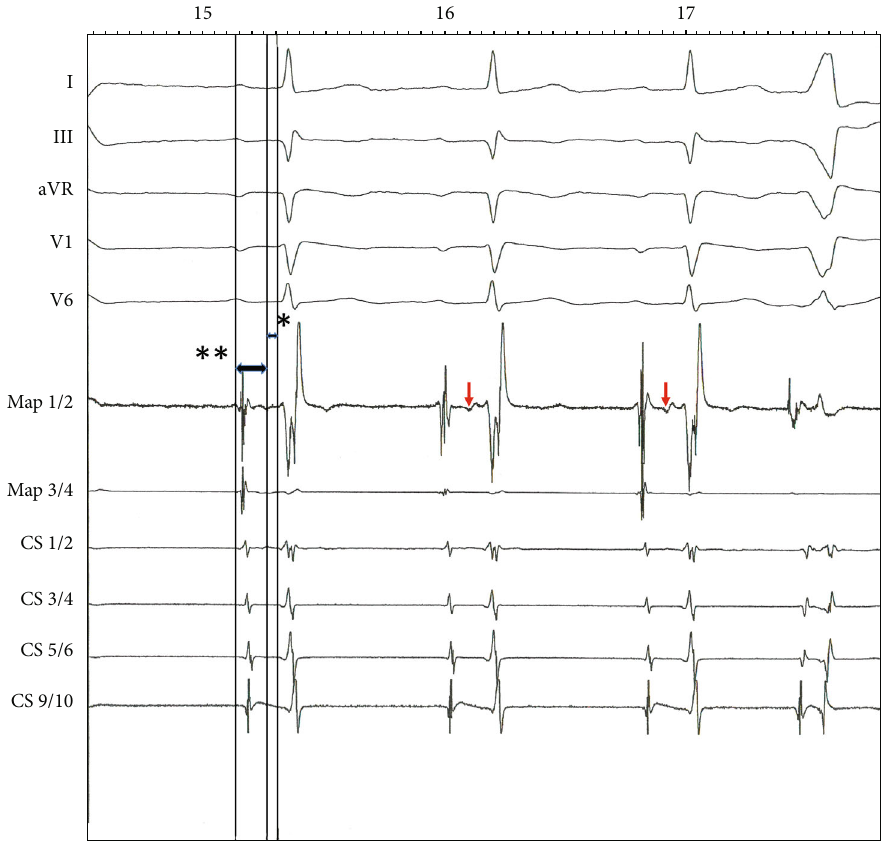
Figure 5: His bundle electrogram (red arrows) immediately performed before the second ablation attempt ( ∗∗ atrioventricular (AV) interval of 128 ms; ∗ His-ventricular (HV) interval of